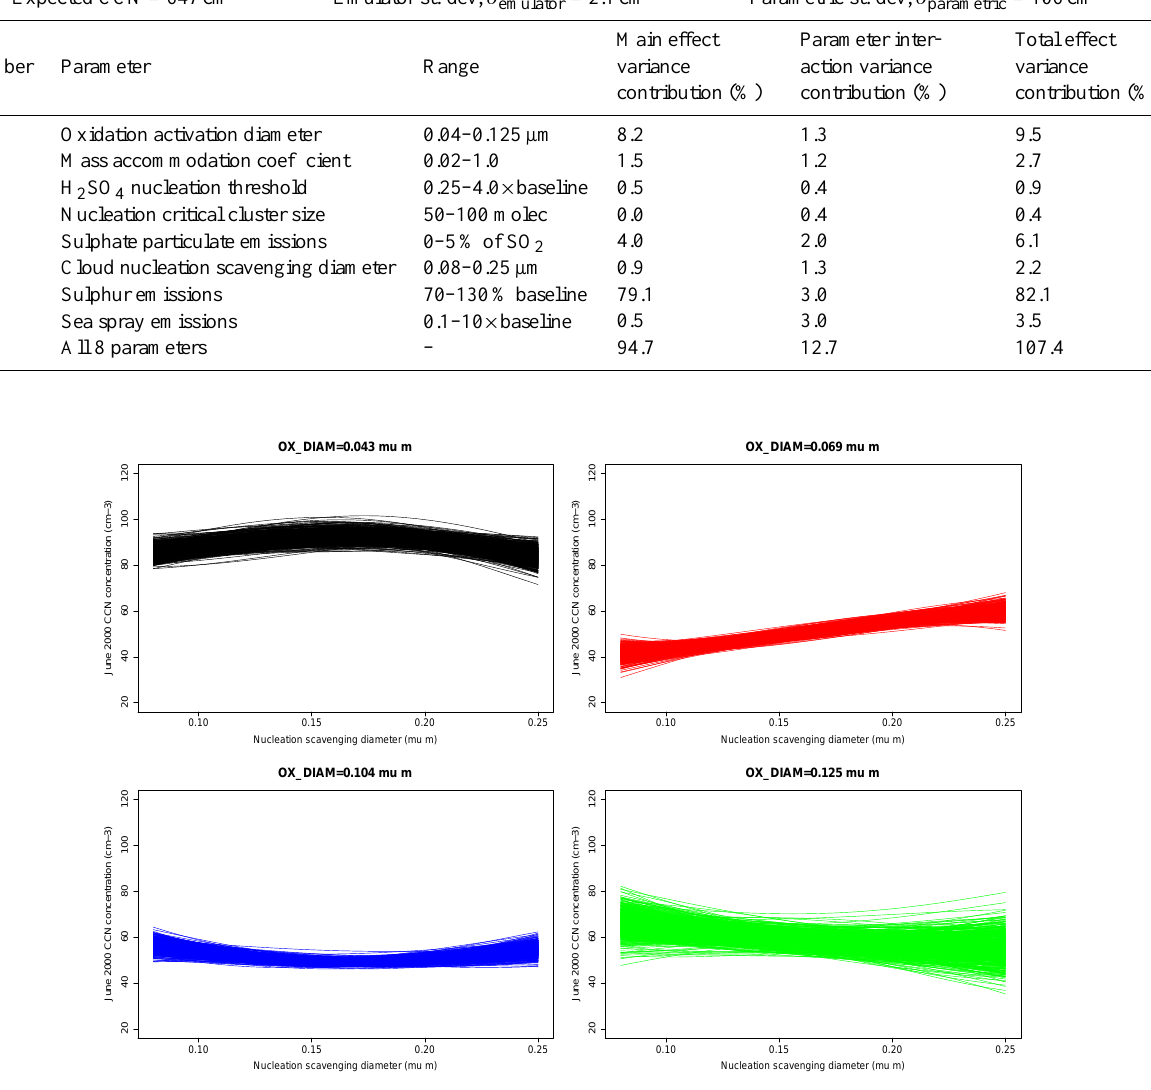
Fig. 9. The joint effect of oxidation activation diameter and nucleation scavenging diameter in the Pacific Ocean grid cell. For four different values of oxidation activation diameter the effect of nucleation scavenging is shown. The sensitivity of CCN concentration to nucleation scavenging is shown to differ (by the shape of the line) when oxidation activation diameter changes. The emulator is less certain in its nucleation scavenging estimate given a high oxidation diameter, as indicated by the spread of the lines. model parameter (Fig. 10b and d) is calculated using separate emulators for each model level. The solid lines in Fig. 10b and d show the main effect of the different parameters and the corresponding dashed lines show the total effect of each